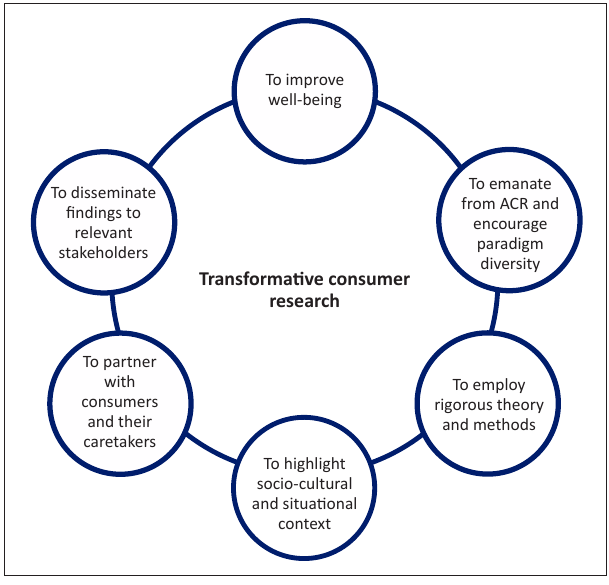
FIGURE 2: The six core qualities and commitments of transformative consumer